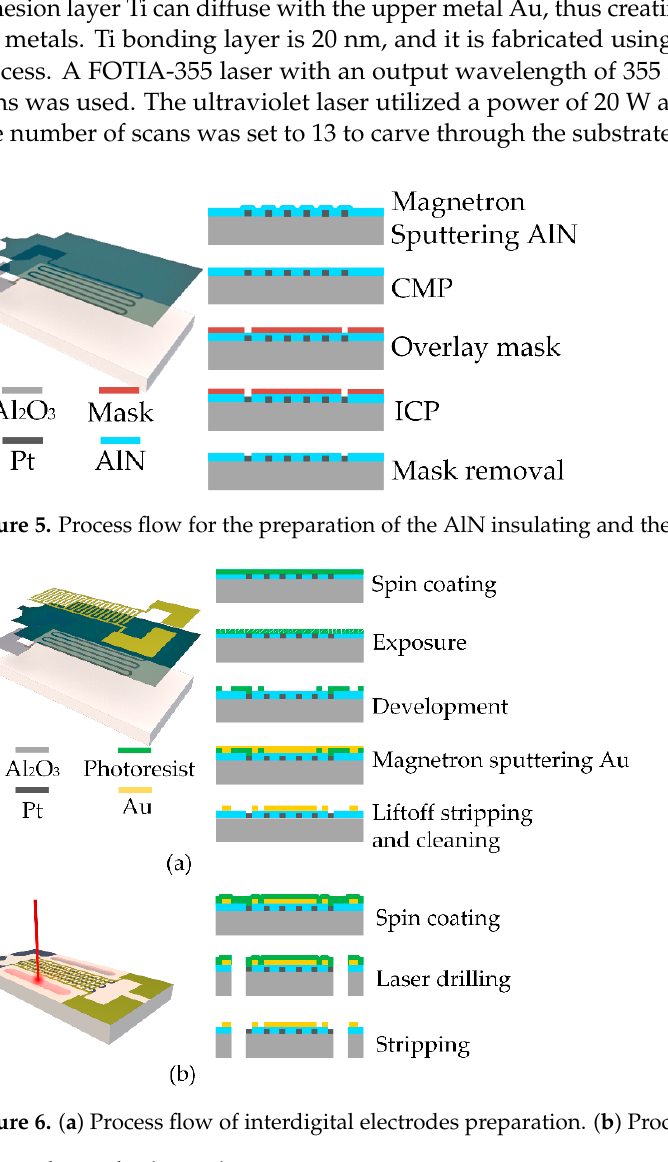
Figure 5. Process flow for the preparation of the AlN insulating and thermally conductive films.